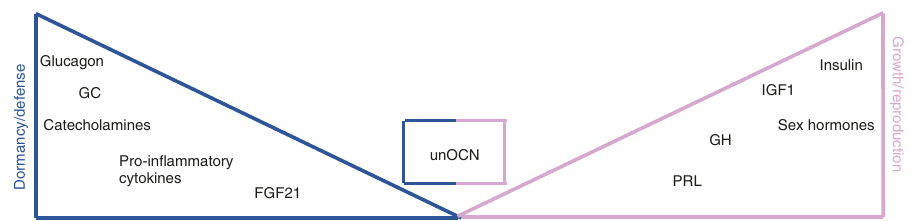
Fig. 4 Endocrine hormones favor distinct biological programs. The balance between the two main life history branches (growth/reproduction vs. dormancy/defense) is heavily shaped by endocrine hormones and other mediators. While the latter do not exclusively promote either branch, their biology typically favors one over the other with varying nuances in between. This may be impressively exempli fi ed by the antagonistic functions of glucocorticoids (catabolic, promote nutrient degradation, inhibit GnRH release) and insulin (anabolic, fosters nutrient storage, promotes GnRH release). Undercarboxylated osteocalcin (unOCN) actively contributes to both branches through its effects on fertility and the acute stress response. How these functions are fi ne-tuned and organized to avoid simultaneous activation of opposing biological responses remains to be determined. GC = glucocorticoids, GH = growth hormone, PRL = prolactin, IGF1 = insulin-like growth factor 1, FGF21 = fi broblast growth factor 21, unOCN = undercarboxylated